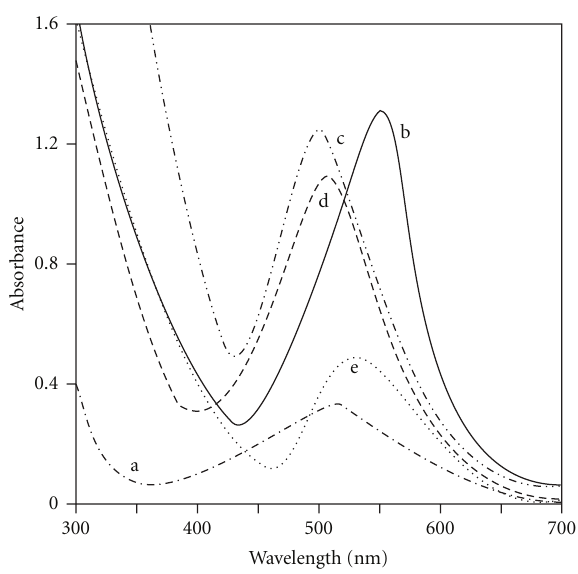
Figure 5: UV-visible spectra of (a)Co(II)(NO 2 ) 2 , (b) [Co(III)(en) 2 · (NO 2 ) 2 ]NO 3 , (c) [Co(III)(en) 2 (NO 2 ) 2 ]NO 3 + AN, (d) [Co(III) · (en) 2 (NO 2 ) 2 ]NO 3 + AN + APS before reaction, and (e) [Co(III)(en) 2 (NO 2 ) 2 ]NO 3 + AN + APS after